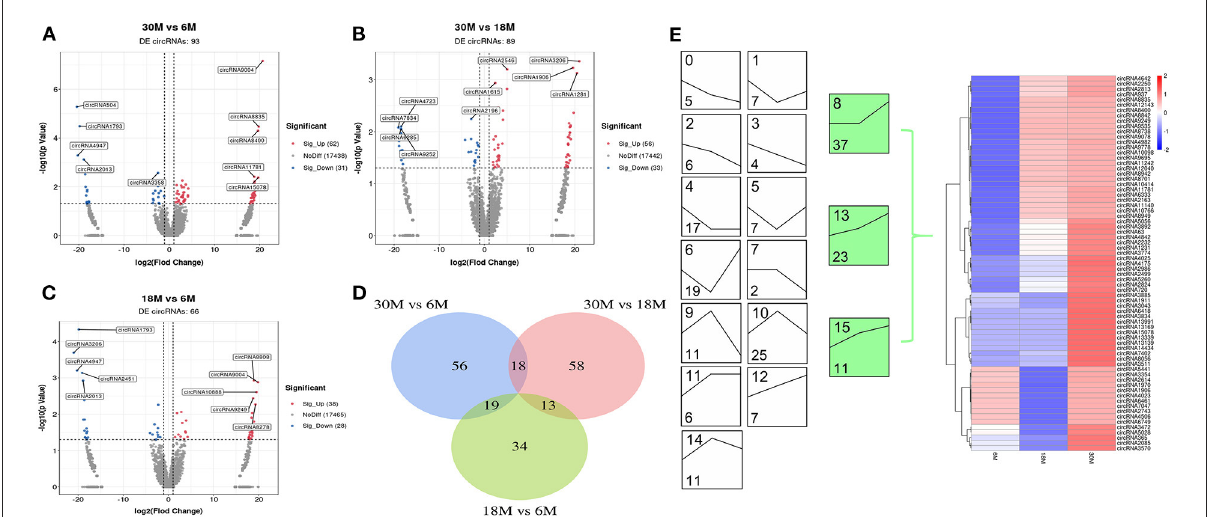
FIGURE3 circRNA differential expression analysis. (A–C) Volcano plot of DE circRNAs. (A) 30M vs. 6M; (B) 30M vs. 18M; (C) 18M vs. 6M. Annotated as the top five DE circRNAs based on P -value. (D) Venn diagram analysis of DE circRNA. (E) DE circRNA expression trend analysis. The upper number indicates the ordinal number of each trend, while the lower number is the number of genes enriched, and those with color are the significantly enriched trends.